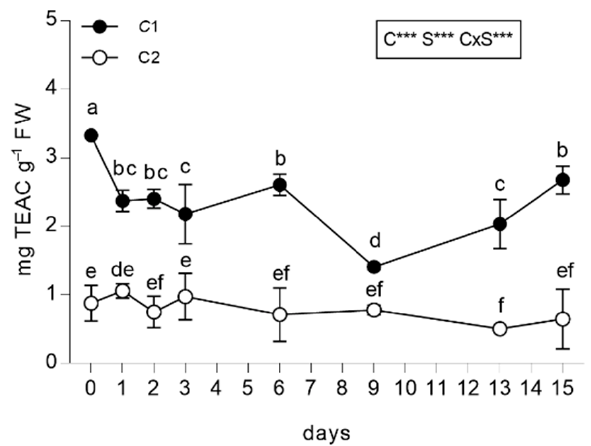
Figure 4. The antioxidant capacity of Rumex acetosa stored at 4 ◦ C for 15 days as fresh-cut products. Closed and open symbols represent first (C1) and second cut (C2) during the growth, respectively. Each value is the mean ( ± SD) of three replicates. Means having the same letter are not significantly di ff erent at p = 0.05 following two-way ANOVA with storage (S) and cut (C) as variables. F values for main e ff ects and their interaction significant at p < 0.001 (***). The antioxidant capacity values were expressed as Trolox equivalents (TEAC) g − 1